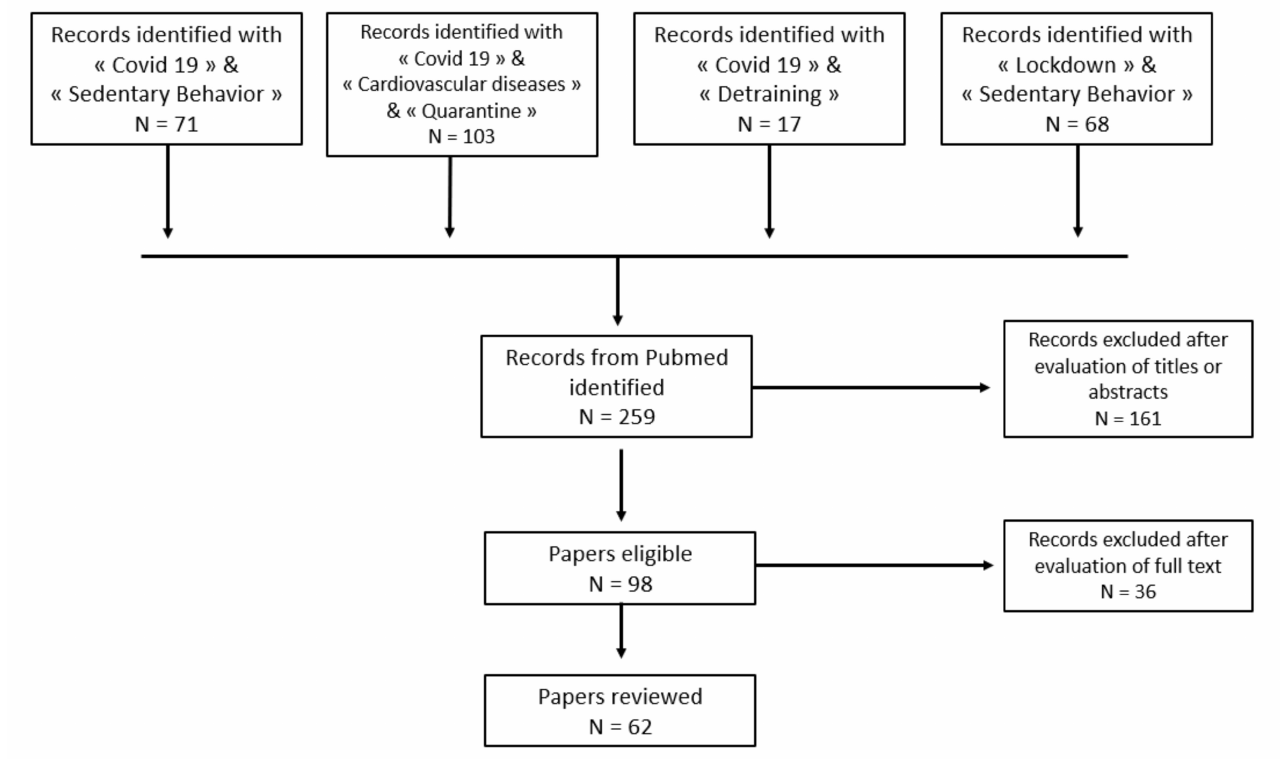
Figure 1. Chart flow of the selection